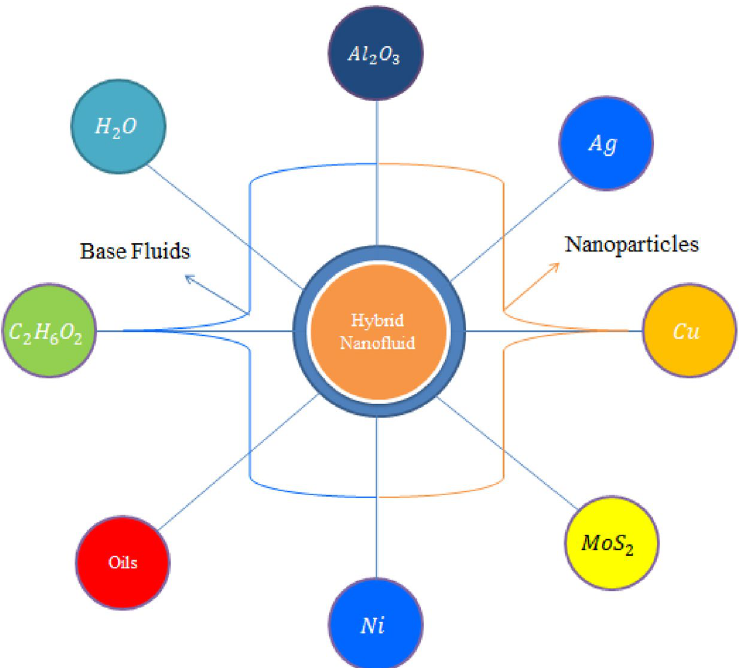
Figure 2. The sketching behavior of hybrid